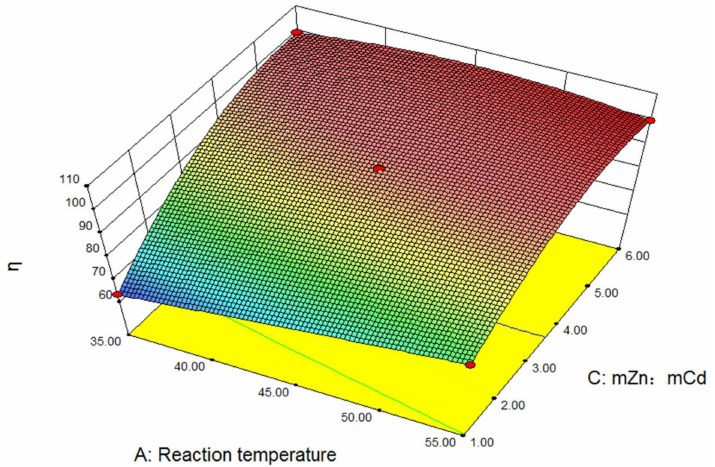
Figure 3. Influence of the reaction temperature and zinc powder dosage on the Cd removal rate.